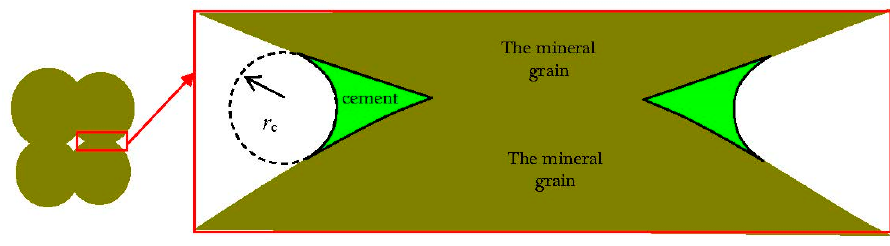
Figure 6. The diagram of the sealing range between two sizes of spherical particles.